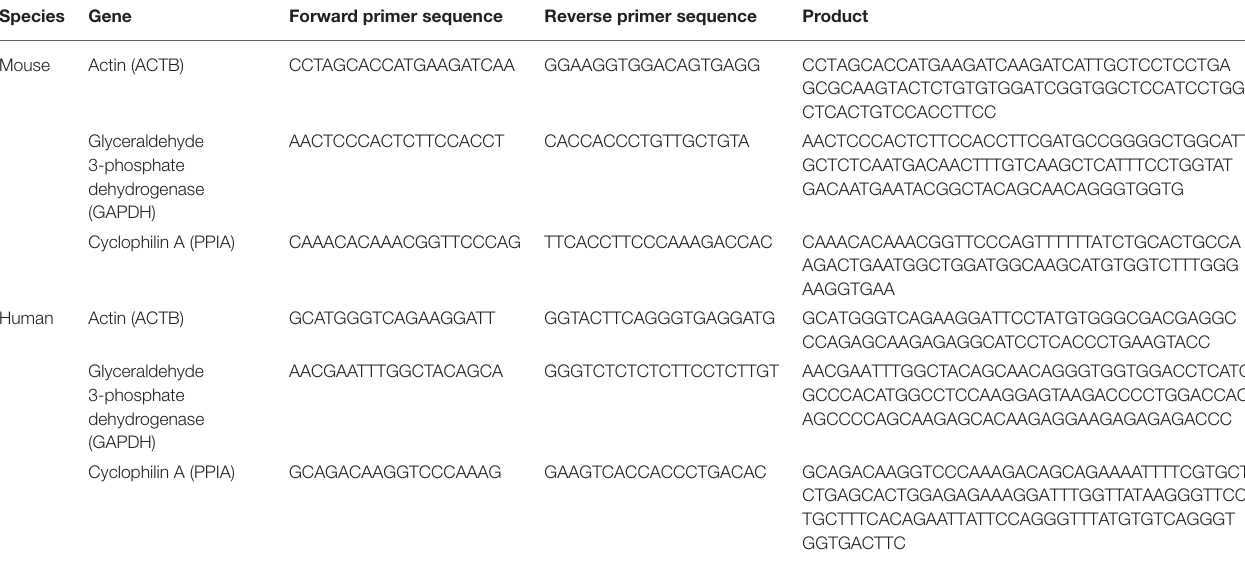
TABLE 3 | Sequences of primers used in qPCR experiments. Species